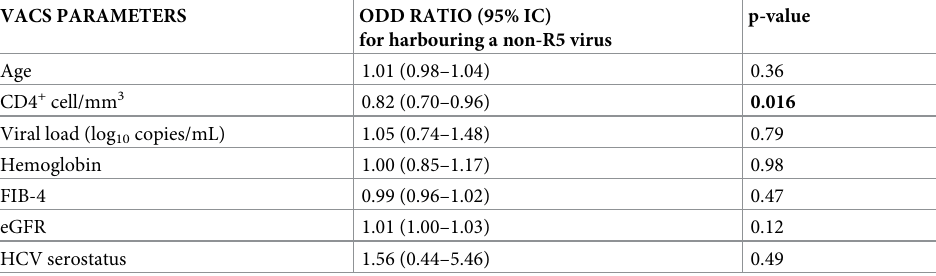
Table 2. Association between coreceptor tropism and individual VACS components.